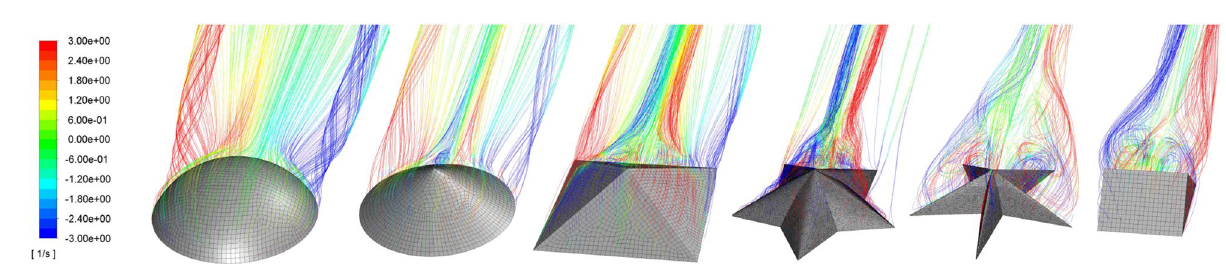
Figure 5. Pathlines of flow over a spherical dome, cone, pyramid, AR = 1.5 sea star, AR = 4.0 sea star, and triangular prism. The pathlines are colored based on the local streamwise vorticity. Objects are placed in order of descending lift force. Figure created using Ansys Fluent 2019 R2 https ://www.ansys